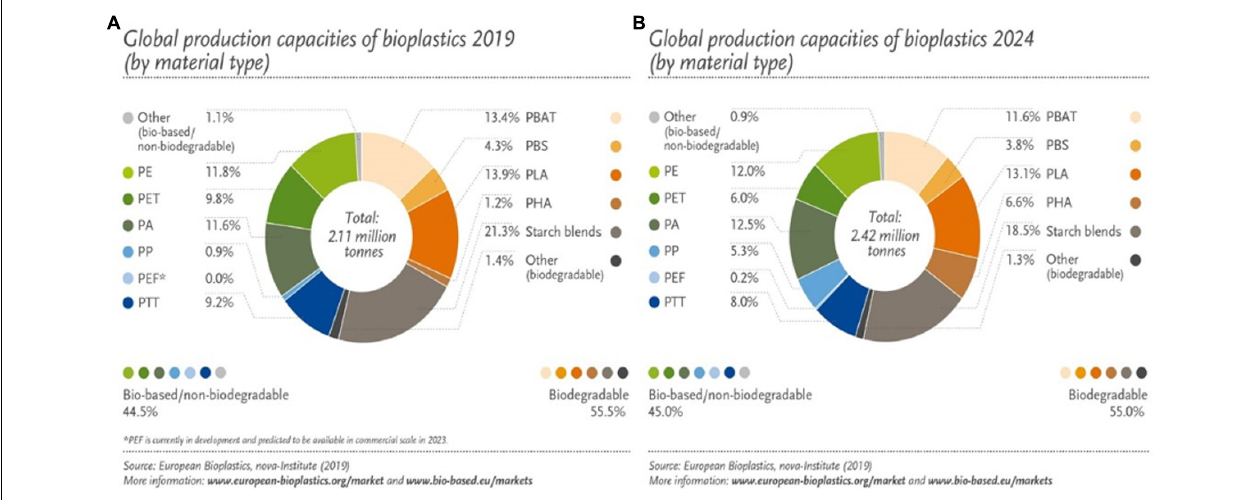
FIGURE 9 | Global production of bioplastics. (A) In 2019, the higher fraction of biobased polymers and biodegradable polymers corresponds to bio-PE and starch blends, respectively. (B) In 2024, the production of biodegradable polymers is expected to increase, mainly due to the significant growth rates of PHA production. PA, polyamide; PEF, polyethylene 2,5-furandicarboxylate; PTT, polytrimethylene terephthalate. Reproduced with permission. Copyright 2017, European Bioplastics, available at